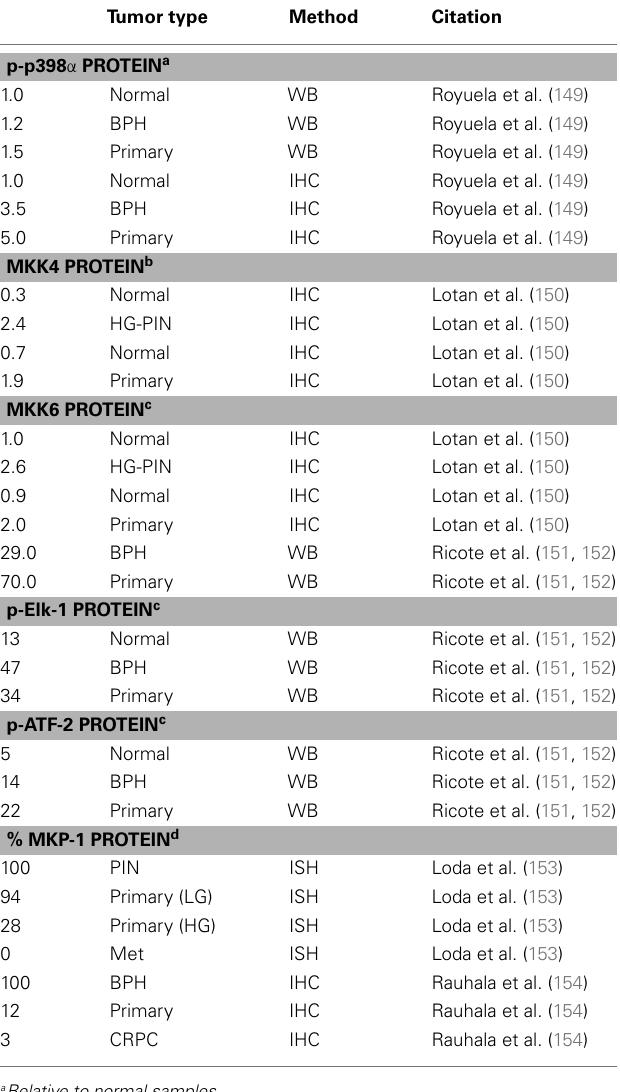
Table 4 | p38 Signaling pathway in PCa